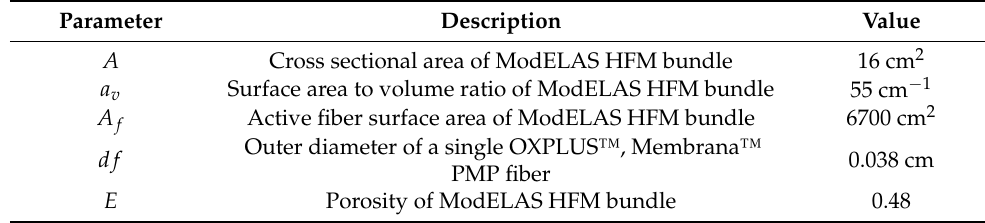
Table 2. Characteristics of ModELAS HFM bundle.